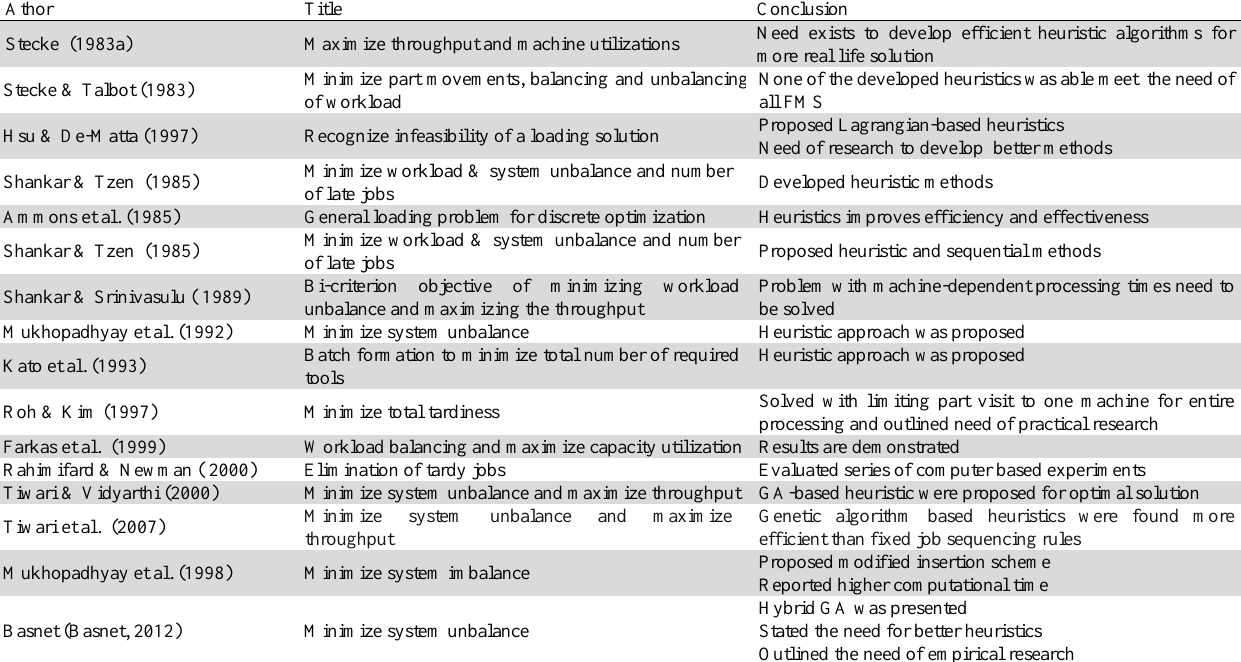
Modelling loading of machines in FMS with